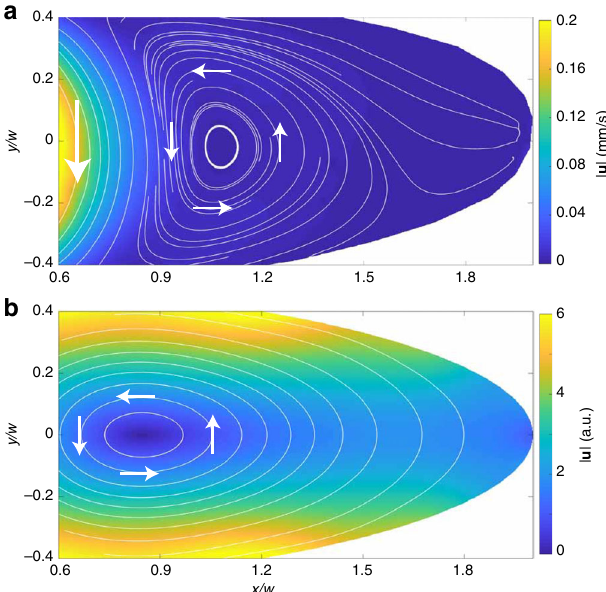
Fig. 4 Experimental and numerical results for e = 0.97. Color map of fl uid velocity magnitude | u | in the cavity region for e = 0.97 from a experiment and b numeric with N = 16. Velocity streamlines and fl ow direction are shown by lines and arrows, respectively